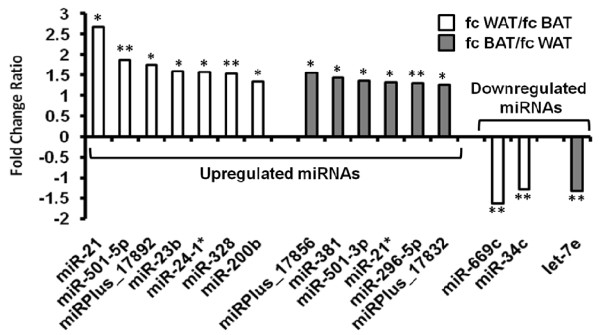
miRNA regulation during adipocyte differentiation. Differences between miRNA regulation during differentiation between white and brown adipocytes are shown as a fold difference (ratio) of fold changes. Student T-test was performed to calculate the significance in these differences. * depicts p < 0.1, ** depicts p < 0.05.